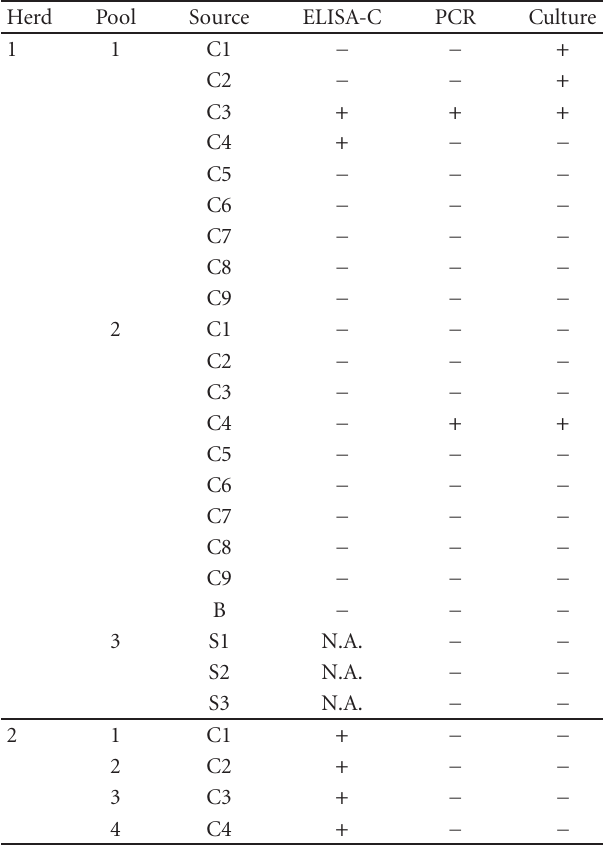
Fecal samples that were a part of the two positive pools of herd 1 ( n = 19) produced four positive results by individual culture (Table 3). All isolates showed no pigmentation and were confirmed as Map by real-time PCR. Two